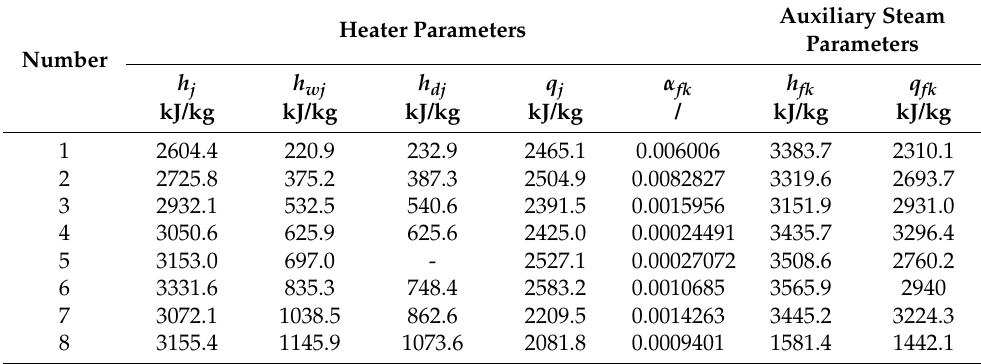
Table 2. Unit thermal